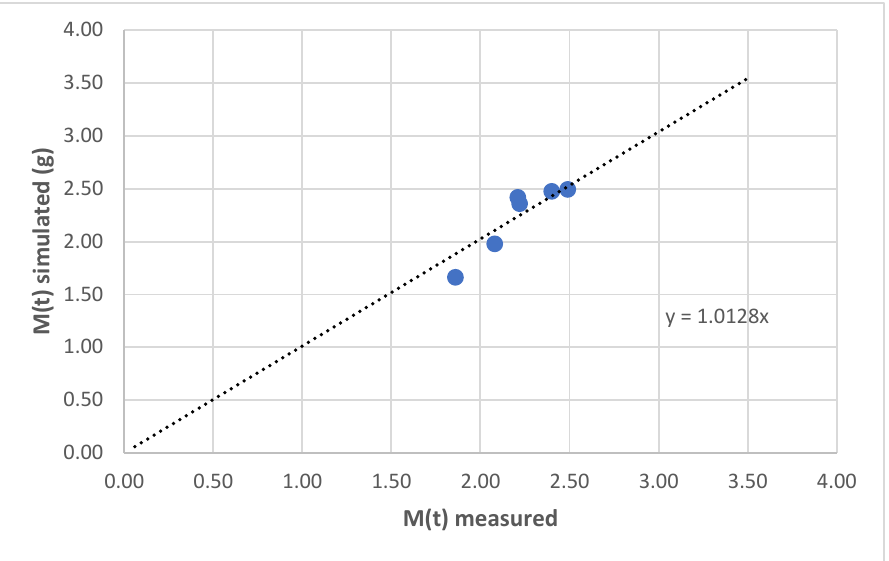
Figure 8. M(t) simulated vs. M(t) measured data over time. It was evident a light overestimation of the model ( M(t) modelled / M(t) measured = 1.0128).